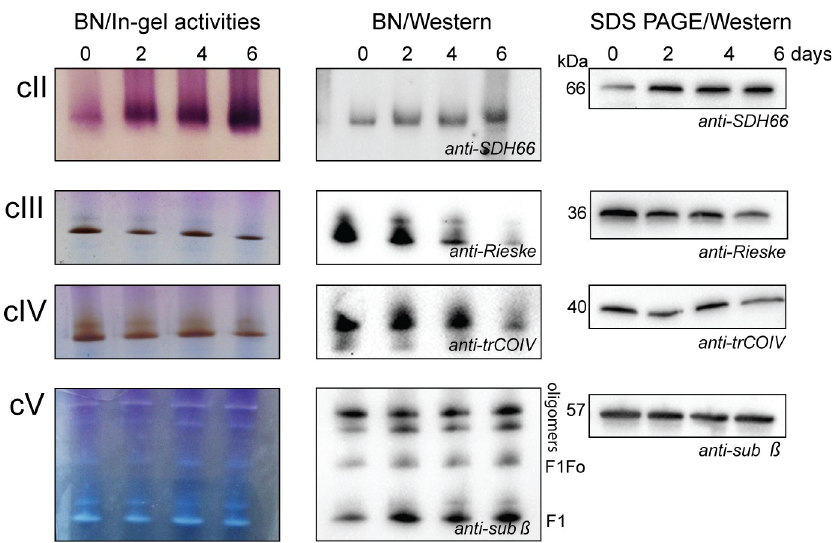
Fig 6. RBP6 OE -induced changes in levels and activities of ETC complexes and F o F 1 -ATP synthase. In-gel activity staining and western blot analysis of respiratory complexes II, III, and IV and F o F 1 -ATP synthase (complex V, cV). Mitochondrial preparations were solubilized using dodecyl maltoside and the same amount of the protein samples was separated on NativePAGE 3%–12% Bis-Tris protein gels followed by in-gel activity staining specific for individual complexes (left panels) or by western blot analysis using specific antibodies (middle panels). Mitochondrial lysates were also evaluated by SDS-PAGE and western blot analysis for individual subunits of complexes II, III, IV, and V (right panels). ETC, electron transport chain; RBP6, RNA binding protein